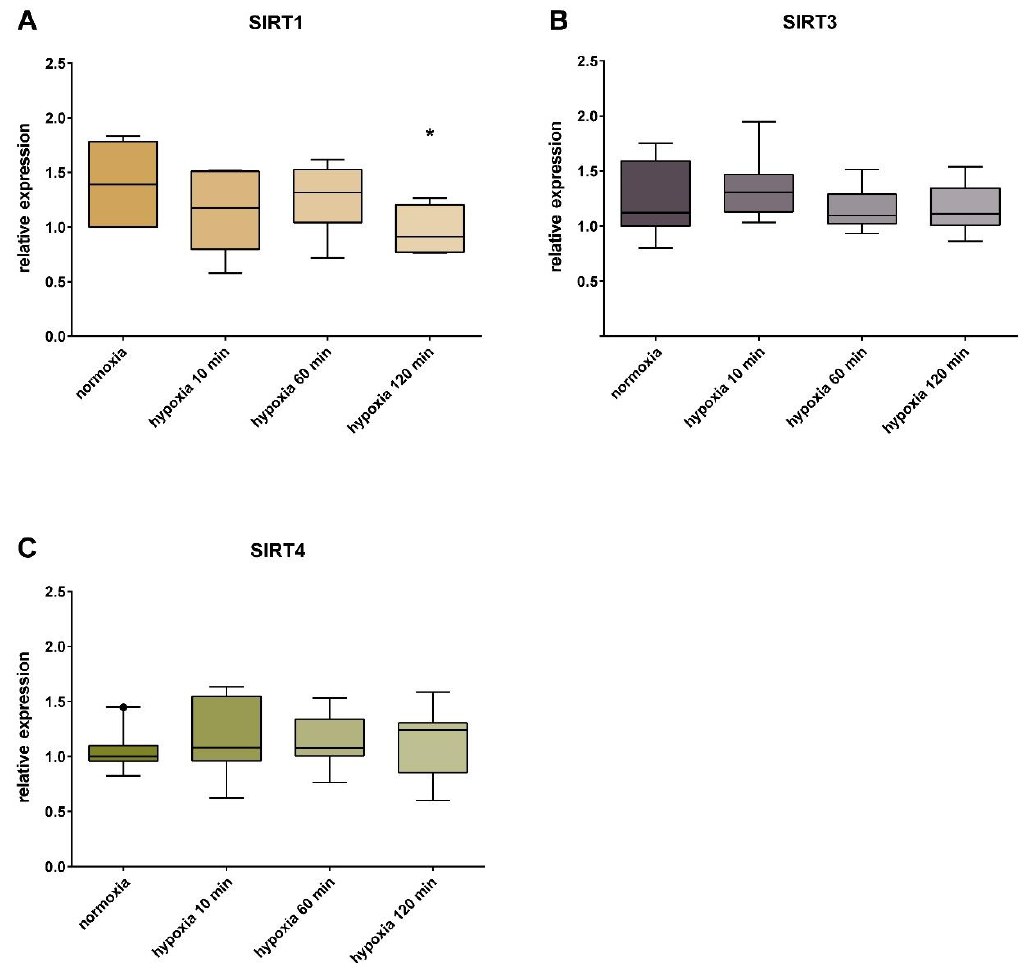
Figure 1. Relative gene expression of sirtuins in human umbilical vein endothelial cells (HUVECs). Expression of SIRT1 ( A ), SIRT3 ( B ), and SIRT4 ( C ) in HUVECs. Controls under the normoxic conditions were compared with cells incubated under hypoxia for 10, 60, and 120 min. Shown are the median, upper, and lower quartile, and the 5% and 95% percentile. Each group had a sample size of n = 3. Significance: * = p < 0.05.